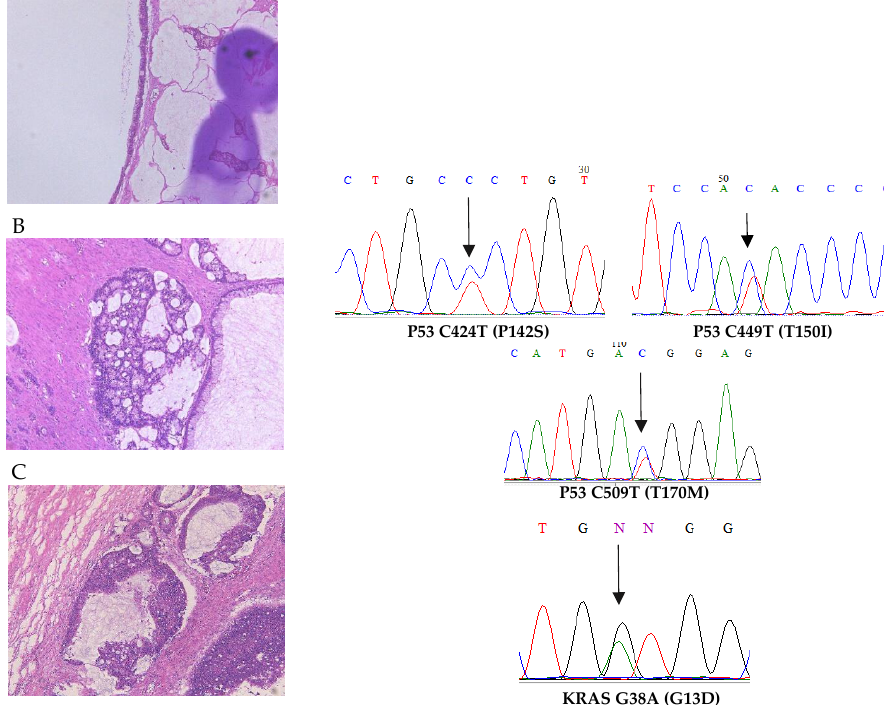
Figure 2. Heterogenous mutation pattern within a tumor according to heterogenous tumor histology (Case 3). ( A ) Mucinous cystadenoma showing no mutation. ( B ) Mucinous borderline tumor showing P142S (424 C > T), T150I (449 C > T), and T170M (509 C > T) mutations in p53. ( C ) Mucinous ovarian carcinoma showing G13D mutation (38 G > A) in KRAS. Mucinous neoplasms of the ovary account for 10 – 15% of ovarian neoplasms. They could be benign, borderline, or malignant. Briefly, mutations in KRAS (55%), CDKN2A (55%, including deletions), TP53 (52%), ARID1A (10%), BRAF (8%), and amplification of HER2 (28%) are the most frequent abnormalities observed in primary mucinous ovarian cancer [13,17 – 22]. Primary ovarian mucinous tumors with mural nodules are very rare. Mural nodules exist in a wide range of types, including anaplastic carcinomas, true sarco- mas, and sarcoma-like mural nodules. Older patients tend to develop mucinous tumors with carcinomatous mural nodules, and have a poor prognosis, with a 50% mortality rate despite adjuvant chemotherapy and/or radiotherapy [23]. One study suggested that ana- plastic mural nodules could be more likely to result from KRAS mutant tumors [24]. An- other study observed aberrant p53 expression in the mural nodules rather than in the mu- cinous components [25]. Until now, a number of studies have documented the genetic alternation of mucinous ovarian carcinomas in a variety of individuals. In our study, seven cases of tumor specimens, including the MCA, MBA, and MOC components to- gether, were used to assess the genetic heterogeneity according to tumor histology. Ana- plastic mural nodules were not observed in any of the cases. In the present study, the heterogeneity of genetic alterations in histological features in mucinous tumors was evaluated, and mutational variability was observed in different areas of the same tumor. Mandai et al. (1998) found that tumors with KRAS mutations